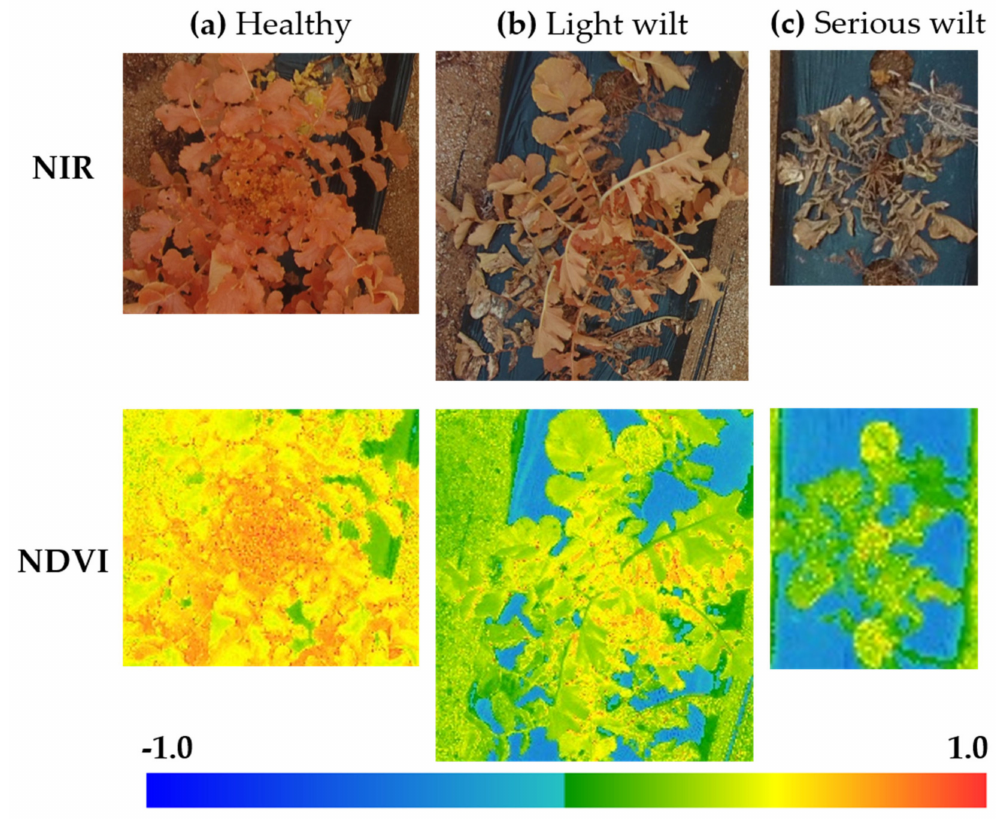
Figure 12. The distinction between three corresponding normalized di ff erence vegetation index (NDVI) maps for radish at di ff erent stages (scaled up to 100% from the original image), including ( a ) healthy, ( b ) light disease, and ( c ) serious disease.